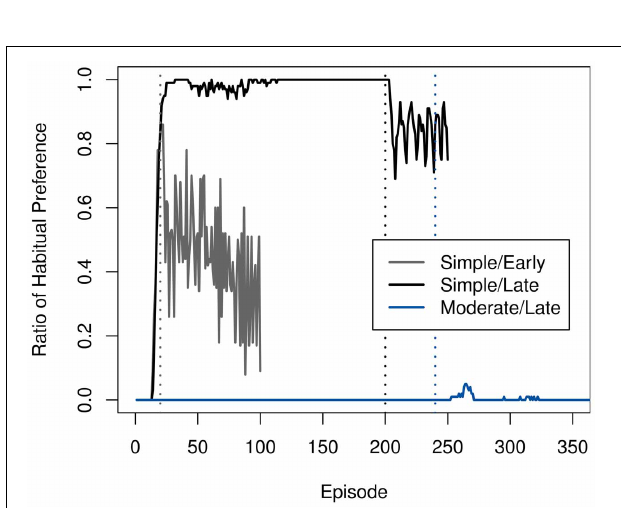
FIGURE 4 | Development of the ratio of selecting the habitual system over the goal-directed one in the starting state in the rat experiment. Ratios in each time step were averaged across 100 runs. Devaluation points are marked using dashed lines in the matching color.